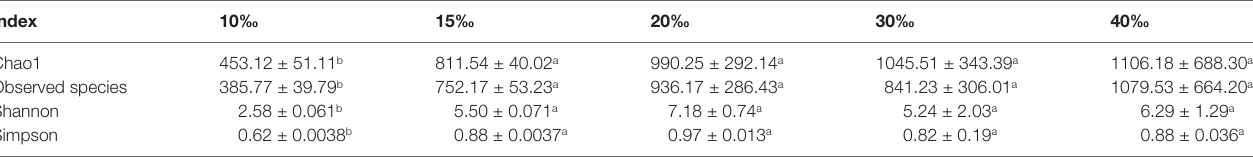
TABLE 2 | Alpha diversity analysis of the intestinal bacteria of U. unicinctus exposed to different salinities.